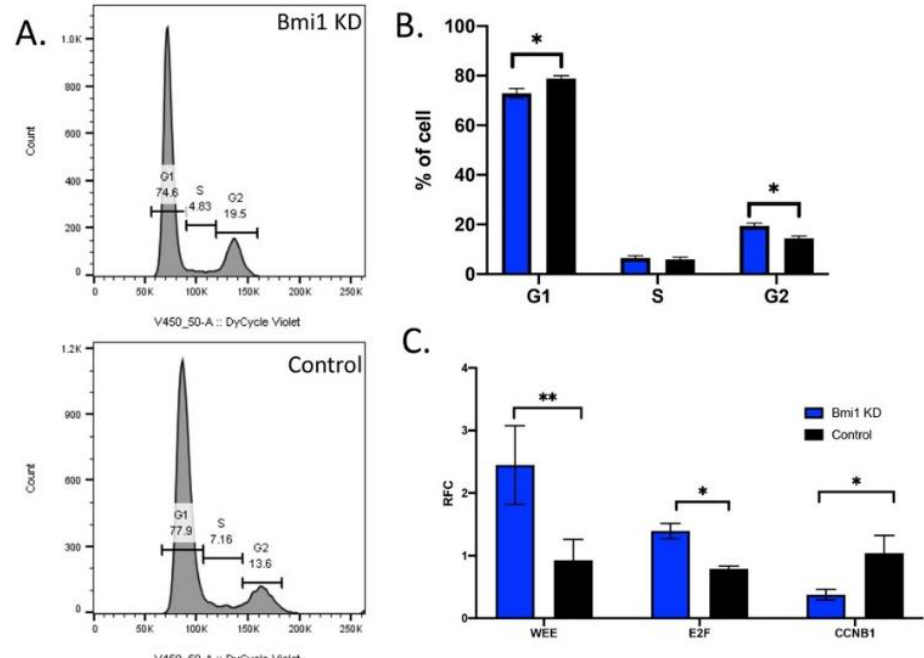
Figure 4. Bmi1 knockdown causes cell cycle arrest in CBSCs: ( A ) representative flow cytometry plots showing the cell cycle profile of serum-starved Bmi1 knockdown or control CBSCs; ( B ) graph showing the relative populations of G1, S, and G2 populations of CBSCs transduced with shBmi1 or shScramble ( p value 0.007 for G1 and p value 0.003 for G2, n = 3); ( C ) the relative fold change (RFC) of PCR analysis shows that Bmi1 knockdown causes a decrease in cyclin B ( p value 0.041), increase in WEE ( p value 0.001), and an increase in E2F ( p value 0.023, n = 3). * p < 0.05, ** p < 0.01.